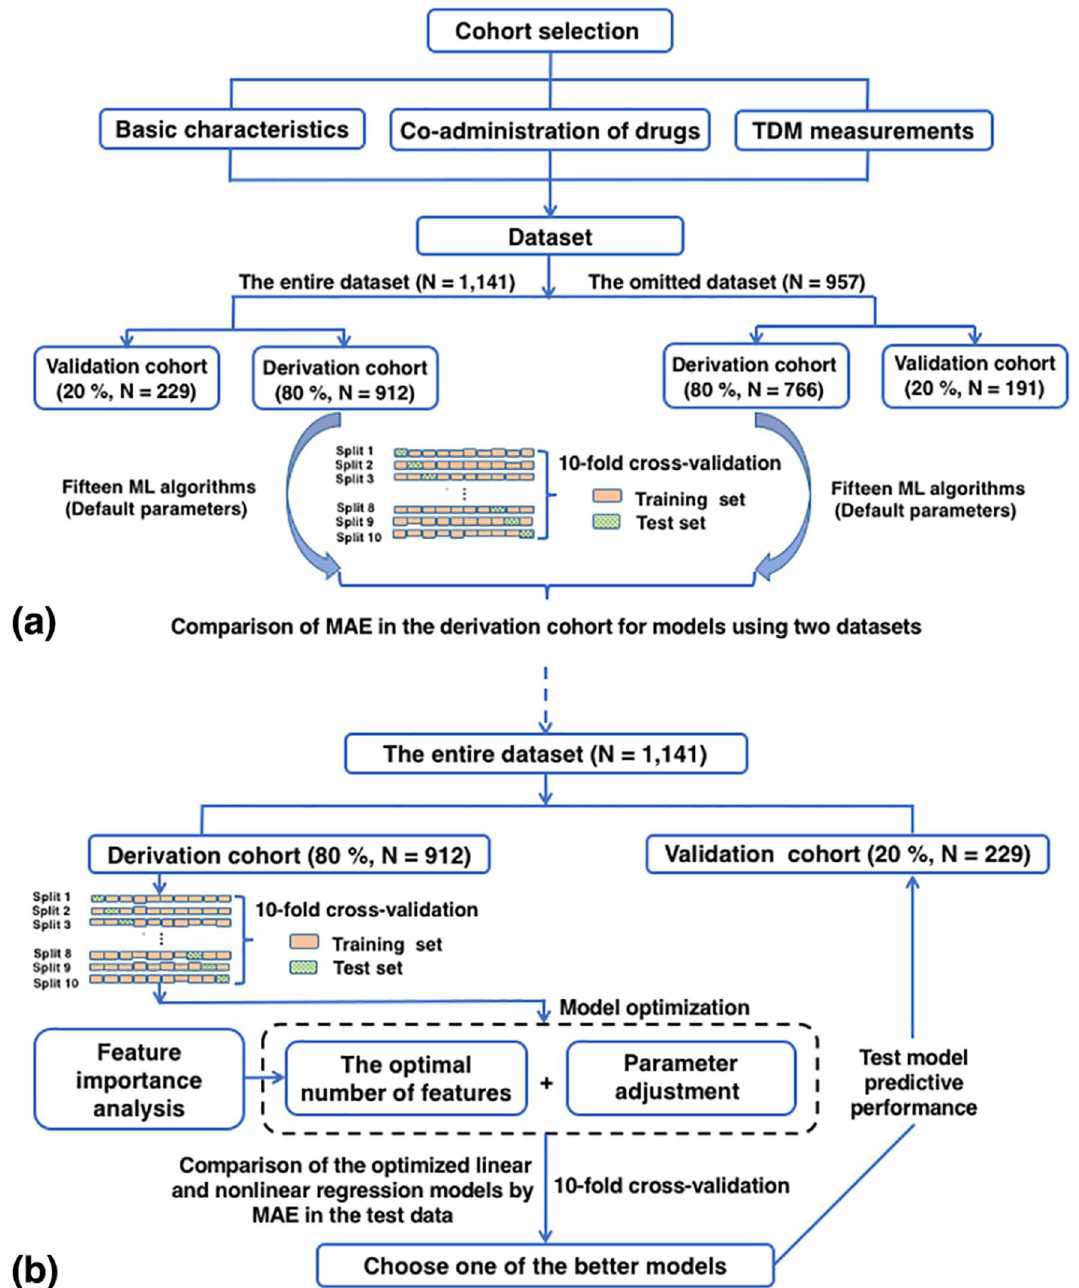
Figure 5. Flowchart of data collection, analysis of missing data, model selection, and model validation. ( a ) Comparisons of models in terms of the MAE on the test data using the entire dataset and the omitted dataset. ( b ) Comparisons of the performance of linear and nonlinear models in terms of MAE on the test data using the entire dataset. MAE mean absolute error, TDM therapeutic drug-monitoring, ML machine Model optimization. Model optimization involved feature selection and parameter adjustment. Before this step, raw data from the entire dataset were randomly split into two batches. Eighty percent (912 measurements) of the TDM measurements were randomly selected as the "derivation cohort" to develop an optimal regression model. The remaining 20% (229 measurements) were assigned to the "validation cohort," which was used to test the performance of the final model in terms of handling unseen samples. Only the derivation cohort was used for feature selection and parameter adjustment. Feature selection, which is crucial for developing a better and simpler model, is the process of selecting a subset of relevant variables (features) to be used for regression by removing redundant and/or irrelevant ones 56 . Here, an embedded approach to feature selection was chosen dur- ing training, together with a suitable regression algorithm, such as the algorithm evaluated here or the random forest regression algorithm, if the evaluated algorithm had no attribute with “feature_importance_.” Features